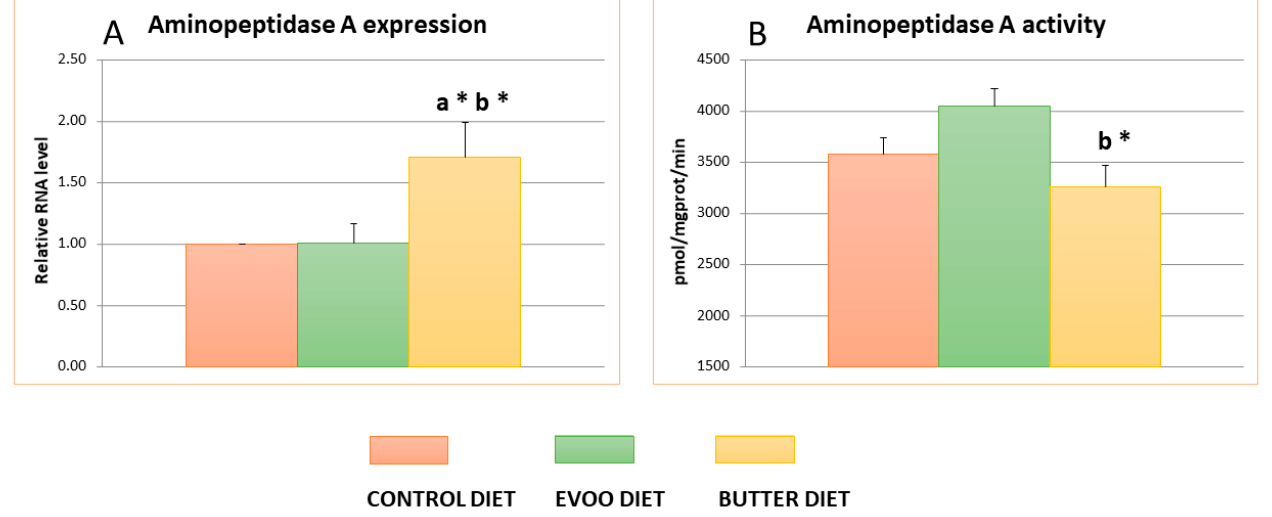
Figure 2. Means values ± SEMs of aminopeptidase A expression ( A ), as relative RNA level and aminopeptidase A activity ( B ), measured as glutamyl aminopeptidase activity, expressed as pmol of β -naphthylamine hydrolyzed per mg of protein and minutes in the hypothalamus of experimental animals (the control, EVOO, and butter diets). a Significant differences between EVOO, butter, and control. b Significant differences between EVOO and butter. * p < 0.05.